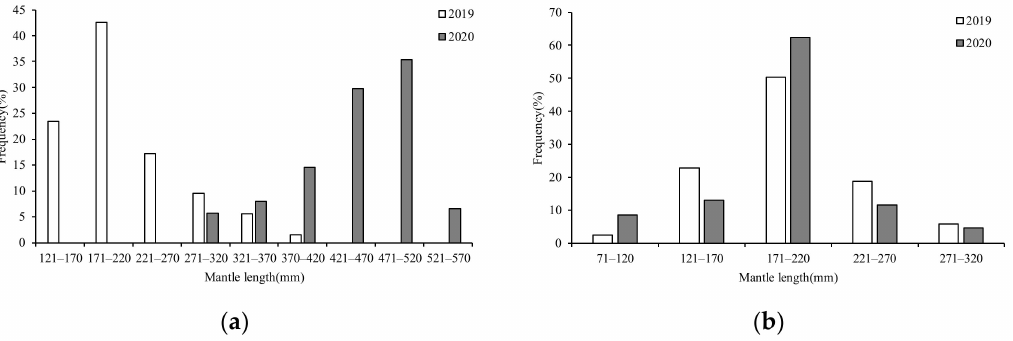
Figure 3. Composition of ML for S. oualaniensis in different years: ( a ) female; ( b )